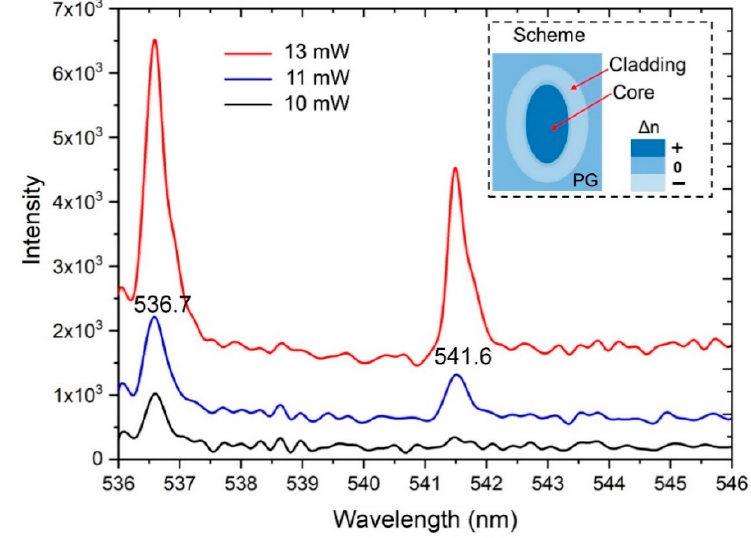
Figure 10. The spectra of laser radiation transmitted through the BWG impregnated with rhodamine and containing ethanol molecules (100%) in the cladding at input powers of 10 (red curve), 11 (blue curve), and 13 mW (black curve). The peaks at 536.7 and 541.6 nm possess an FWHM bandwidth of ~0.5 nm. The inserted image is a schematic diagram of the BWG refractive index distribution in the cross-section.